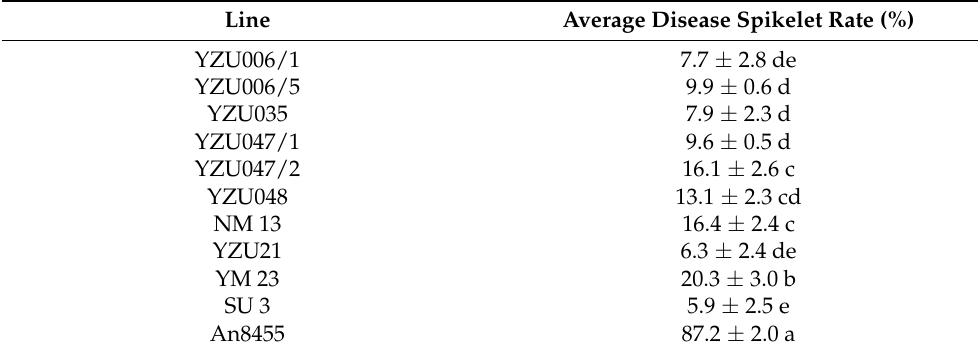
Figure 4. The phenotype of FHB resistance of six new breeding lines by single spikelet inoculation method at 21 after inoculation. Table 3. Evaluation of resistance to FHB of new germplasm.